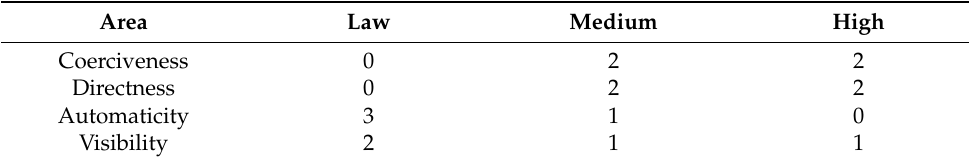
Table 8. Number of tools by degree of public